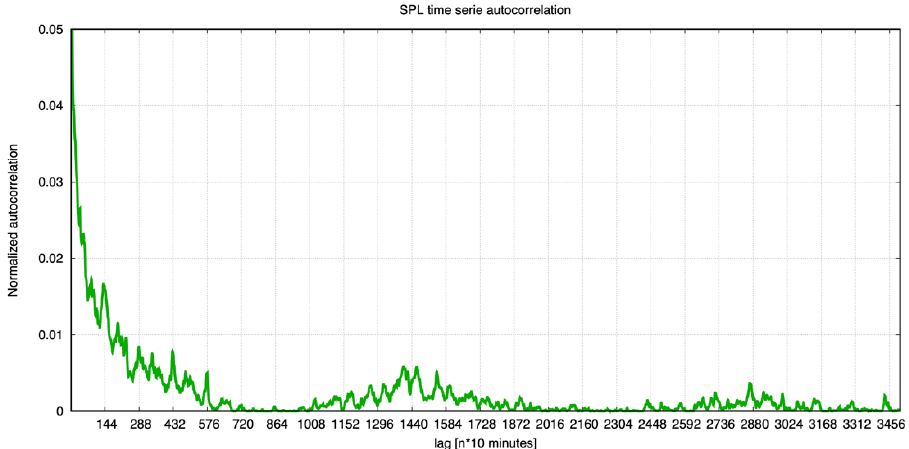
Figure 14. Autocorrelation of the cumulative SPL during the period 11/21/2020 and 2/13/2021.